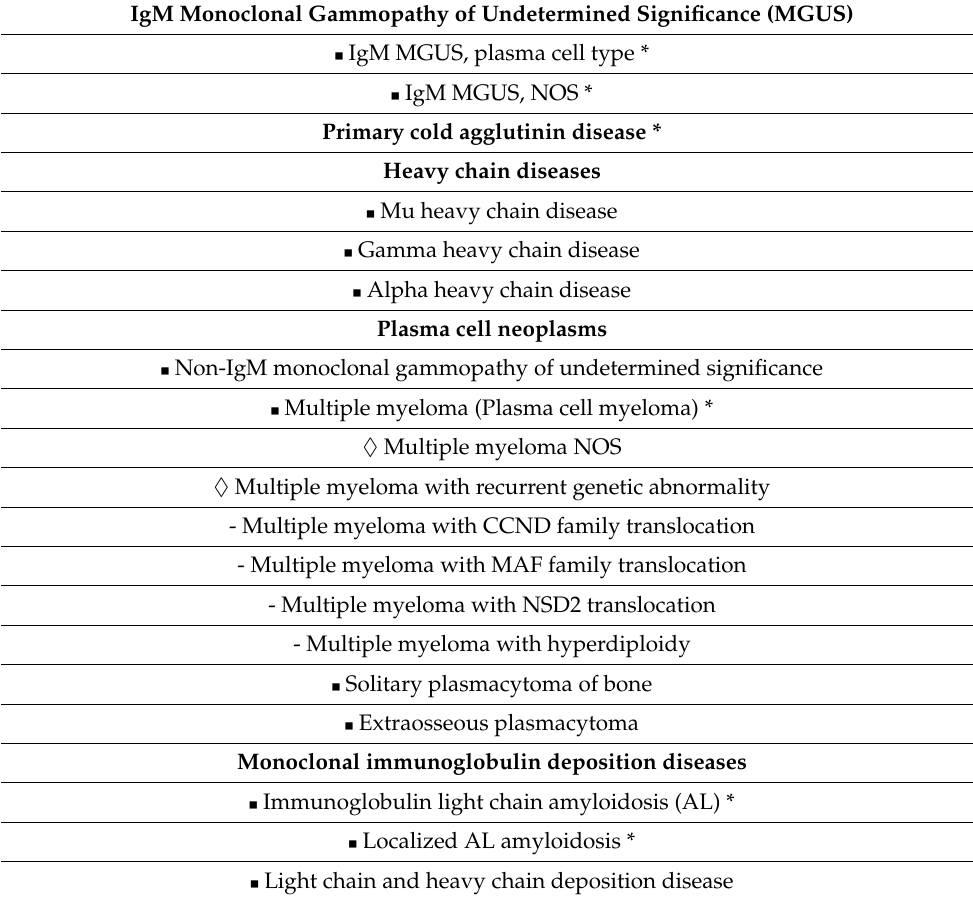
Table 2. International Consensus Classification of Mature B-cell Neoplasms. Table 1. Plasma cell neoplasms and other diseases with paraproteins. Table 1. Plasma cell neoplasms and other diseases with paraproteins.